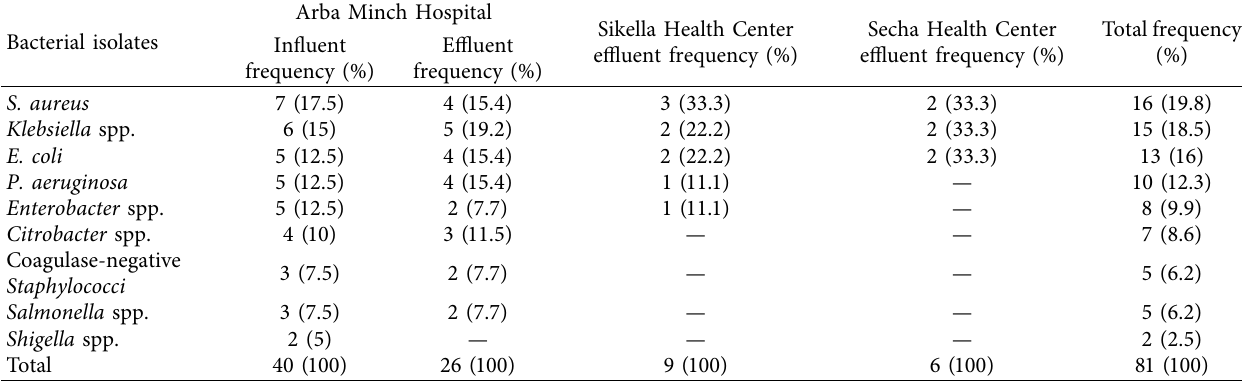
Table 1: Frequency of bacterial isolates from influent and effluent wastewater released from health facilities. Arba Minch Hospital Bacterial isolates Klebsiella spp.